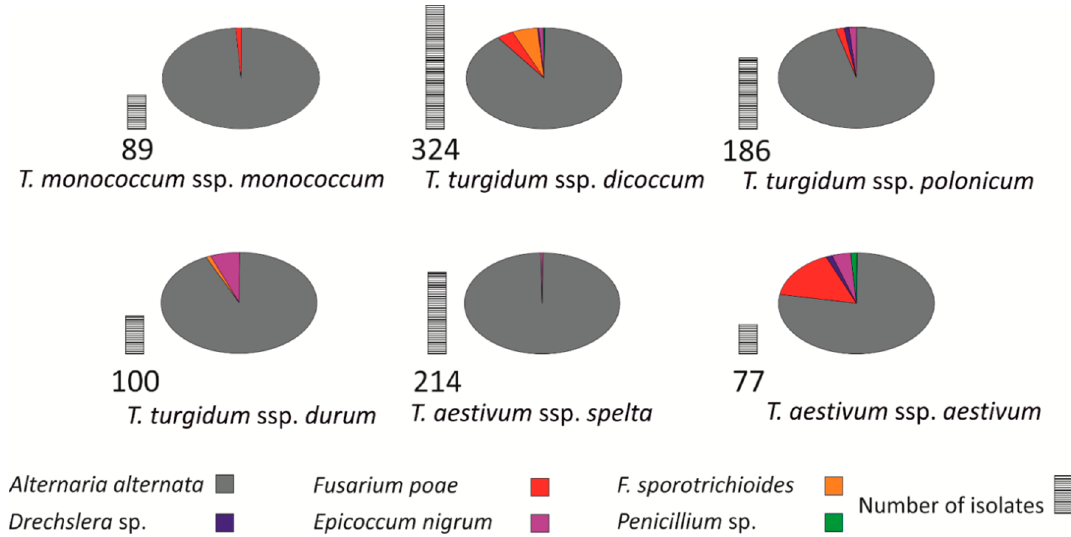
Figure 4. Colonization of wheat grain by endophytic fungi. The vertical bars represent the counts of fungal colonies in wheat grain. fungal colonies in wheat